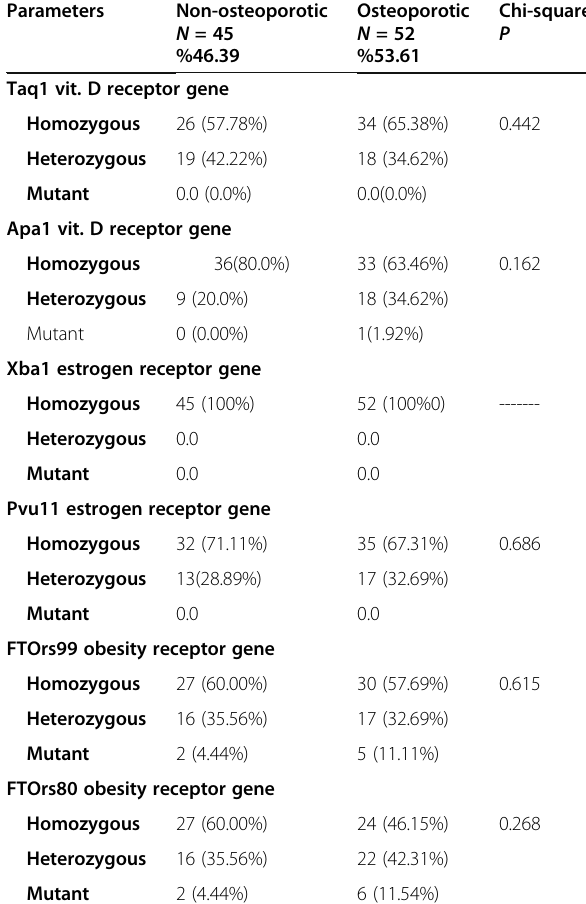
Table 1 Distribution of genotypes of vitamin D receptors, estrogen receptors, and obesity receptors in studied non- osteoporotic and osteoporotic women